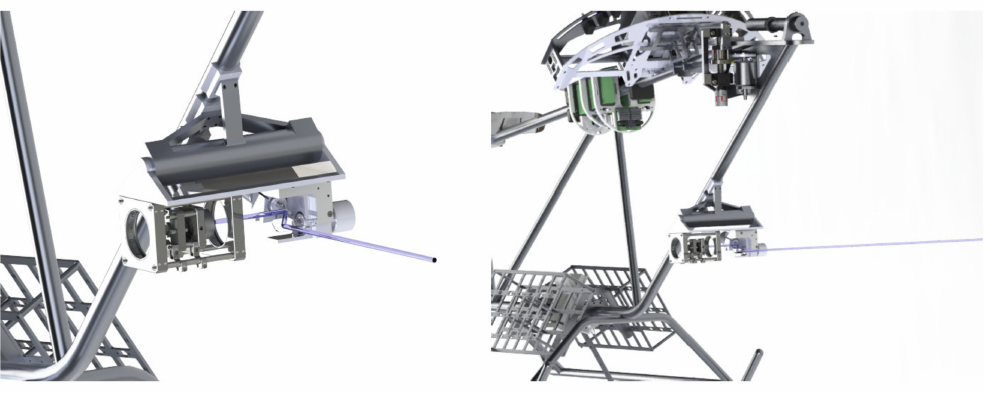
Figure 8. System mounted on the hoverbike. The transparent blue line represents the laser